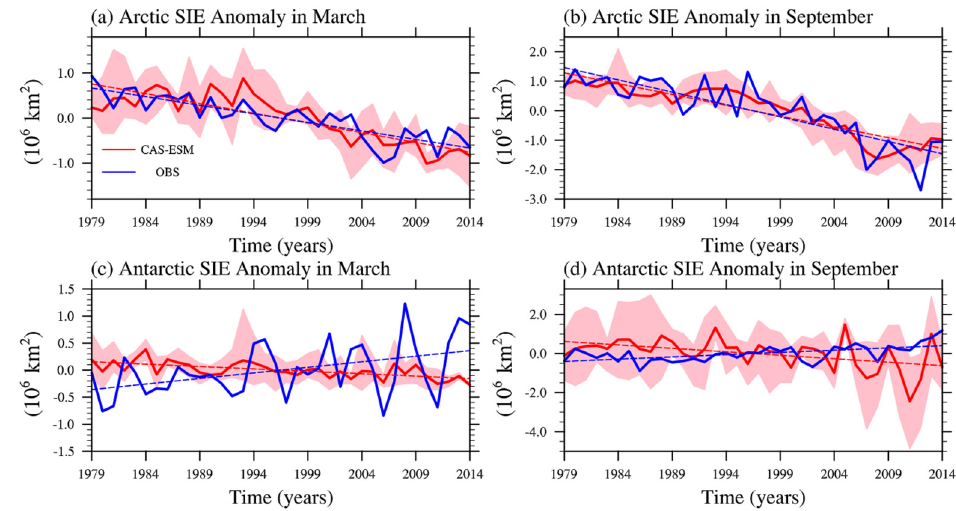
Figure 1. Time evolution of ensemble mean SIE anomalies in Arctic and Antarctic in historical simulation. The figures ( a , b ) show the anomaly in Arctic SIE in March and September respectively, and the figures ( c , d ) show the corresponding Antarctic. Red and blue lines indicate CAS-ESM 2.0 and observations, respectively. Anomalies were calculated from 1979–2014 average. Pink areas represent simulated anomaly ranges of four simulations. Dashed lines represent linear trend of CAS-ESM 2.0 and observations. SIE is areal sum of all grid points whose sea ice concentration exceeds 15%.